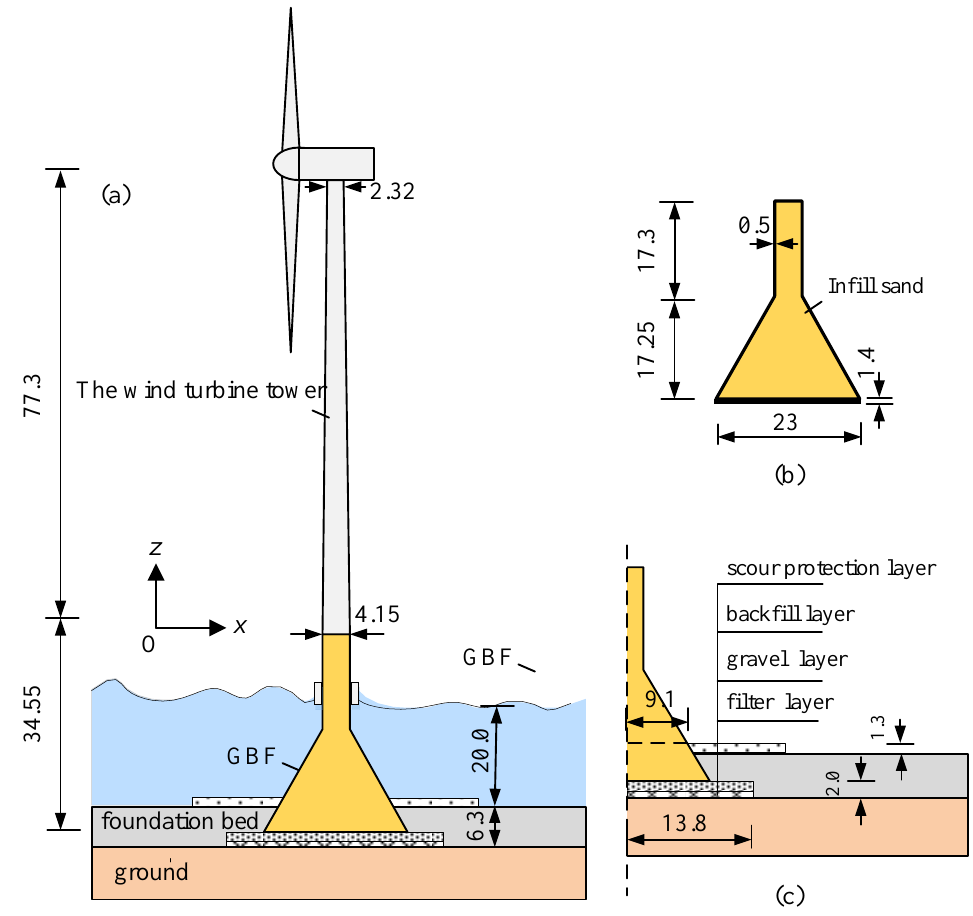
Figure 6. Schematic of the OWT on GBF: ( a ) lateral view; ( b ) dimension of the GBF; ( c ) dimension of the foundation bed (unit: m).